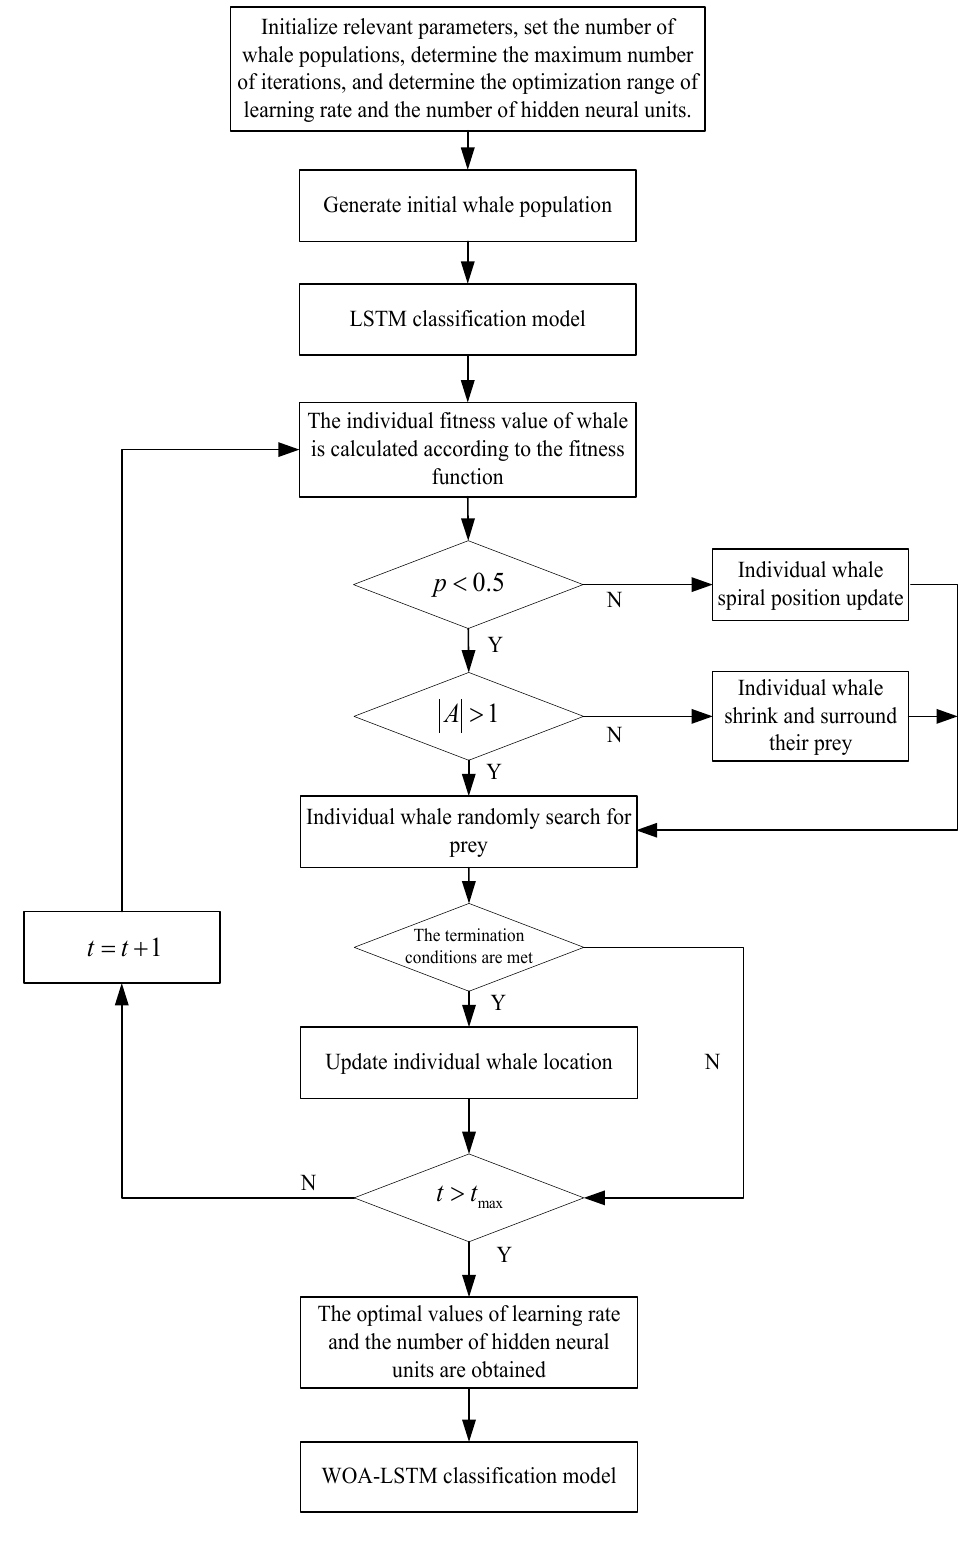
Figure 2. Flow chart of the WOA-LSTM model.